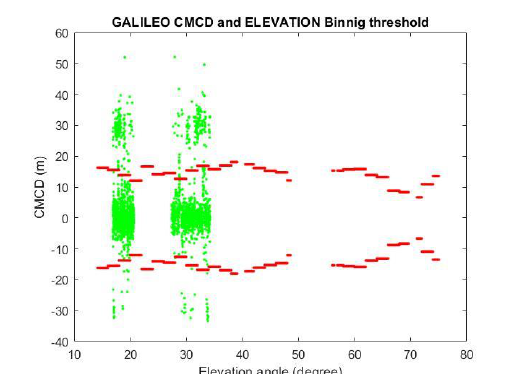
Figure 6. Coloured dots that bigger or smaller values than red values are accepted as Galileo CMCD measurements (Green dots are Galileo CMCDs and red lines are acceptable threshold)